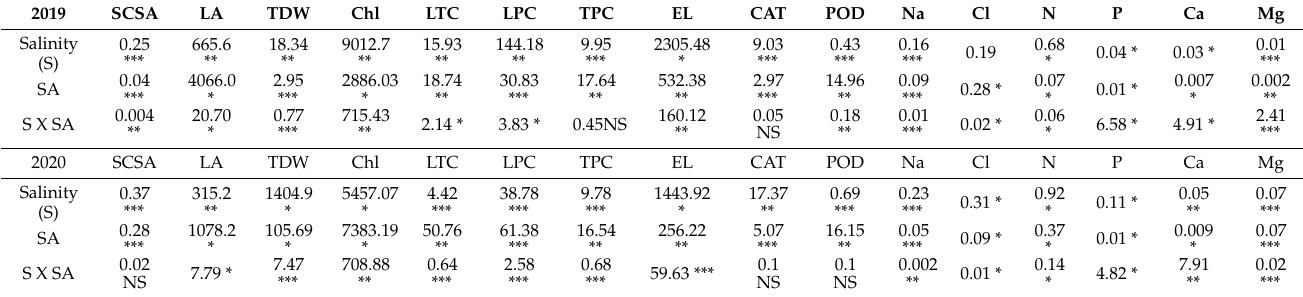
Table 1. Results of the analysis of variance with mean square testing the effects of salinity levels (S), salicylic acid (SA), and their interactions on stem cross-sectional area (SCSA), leaf area (LA), total dry weight (TDW), chlorophyll content (Chl), total phenol content (TPC), leaf total carbohydrates (LTC), leaf proline content (LPC), catalase activity (CAT), peroxidase (POD), sodium (Na), chloride (Cl), nitrogen (N), phosphorus (P), potassium (K), calcium (Ca), and magnesium (Mg) in 2019 and 2020